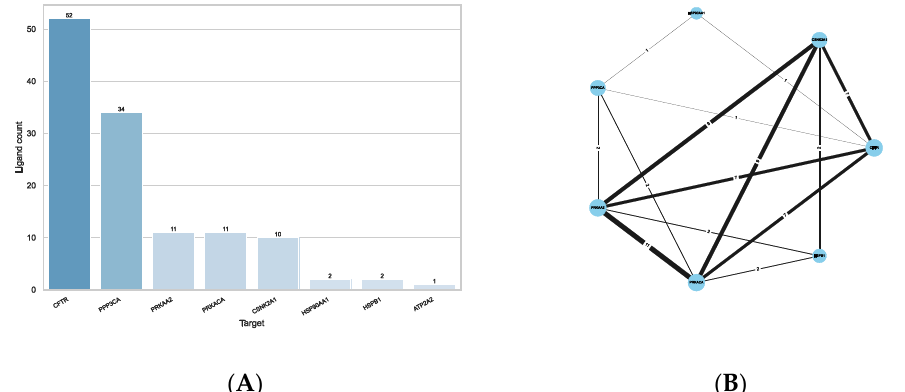
Figure 8. Results from the ligand-based approach using the 35 selected targets. ( A ) Number of ligands associated with each target. ( B ) Protein – Ligand-Interaction network. Each nodes (circle) stands for one target, while the edges (lines) connecting them represent the number of common ligands (=number on edge) associated with them by either method. The thicker the edge, the more ligands two targets share. The size of the nodes represents their degree, i.e., the number of other nodes they are connected to.